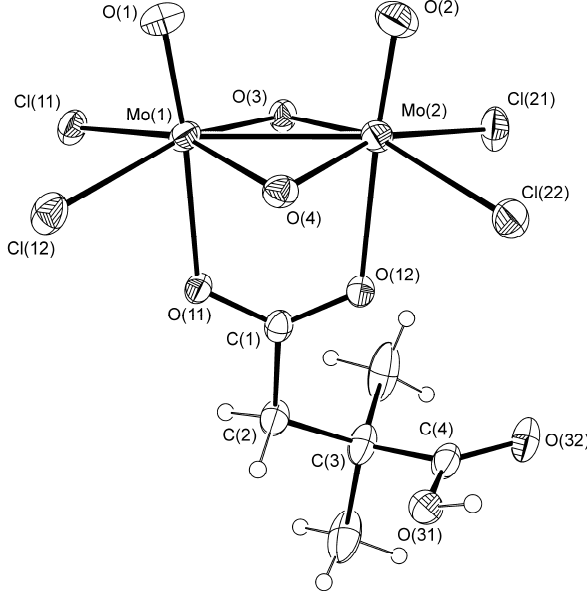
Figure 3. ORTEP drawing of [Mo ellipsoids are drawn at the 30% probability level. Hydrogen atoms are shown as spheres of arbitrary